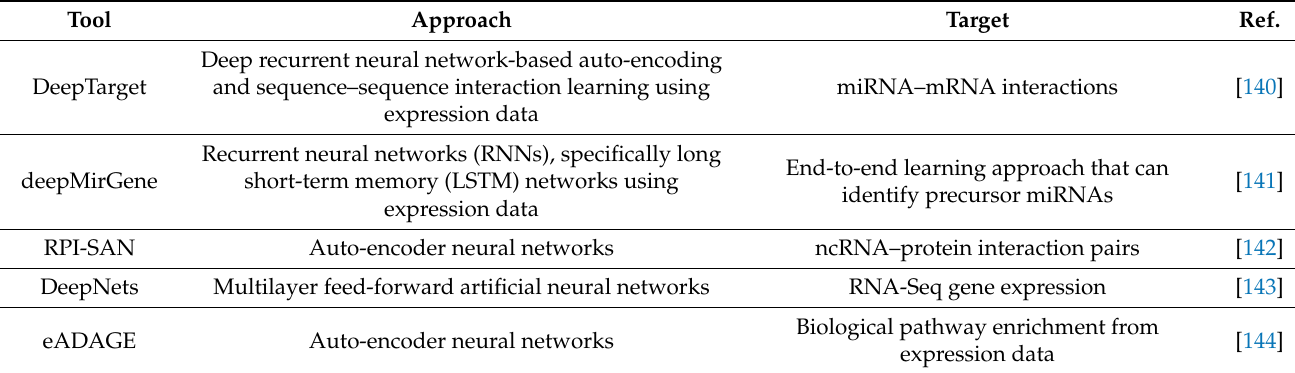
Table 1. List of deep learning methodologies in